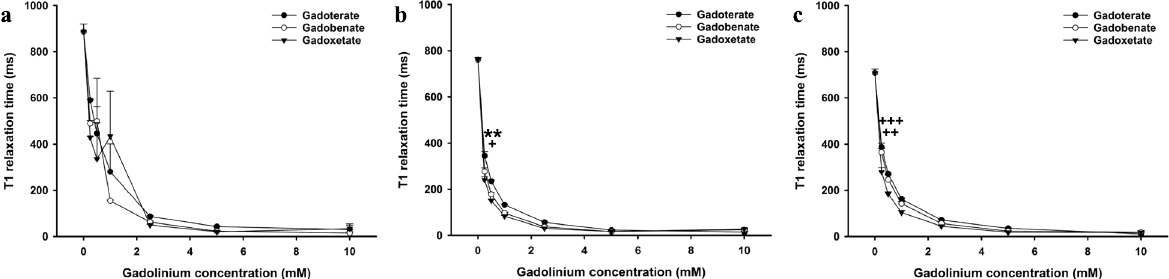
Fig. 5 T1 relaxation time of gadoterate, gadobenate, and gadoxetate on 2D MIXED sequence. T1 relaxation time of gadoterate, gadobenate, and gadoxetate at different concentrations in saline ( a ), blood ( b ), and bile ( c ) on 2D MIXED sequence. * significantly higher maximum signal intensity = of the contrast agent than both other contrast agents; significantly higher maximum signal intensity than the contrast agent with the lowest + = maximum signal intensity. * or p < 0.050, ** or p < 0.010; *** or p < + = + + = + + + =